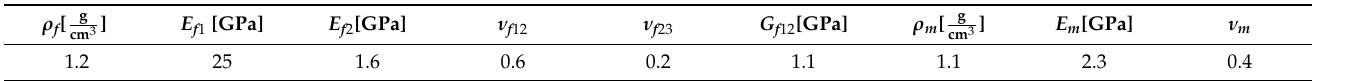
Table 1. Parameters of sisal fiber (index f ) and epoxy matrix (index m ) for effective properties